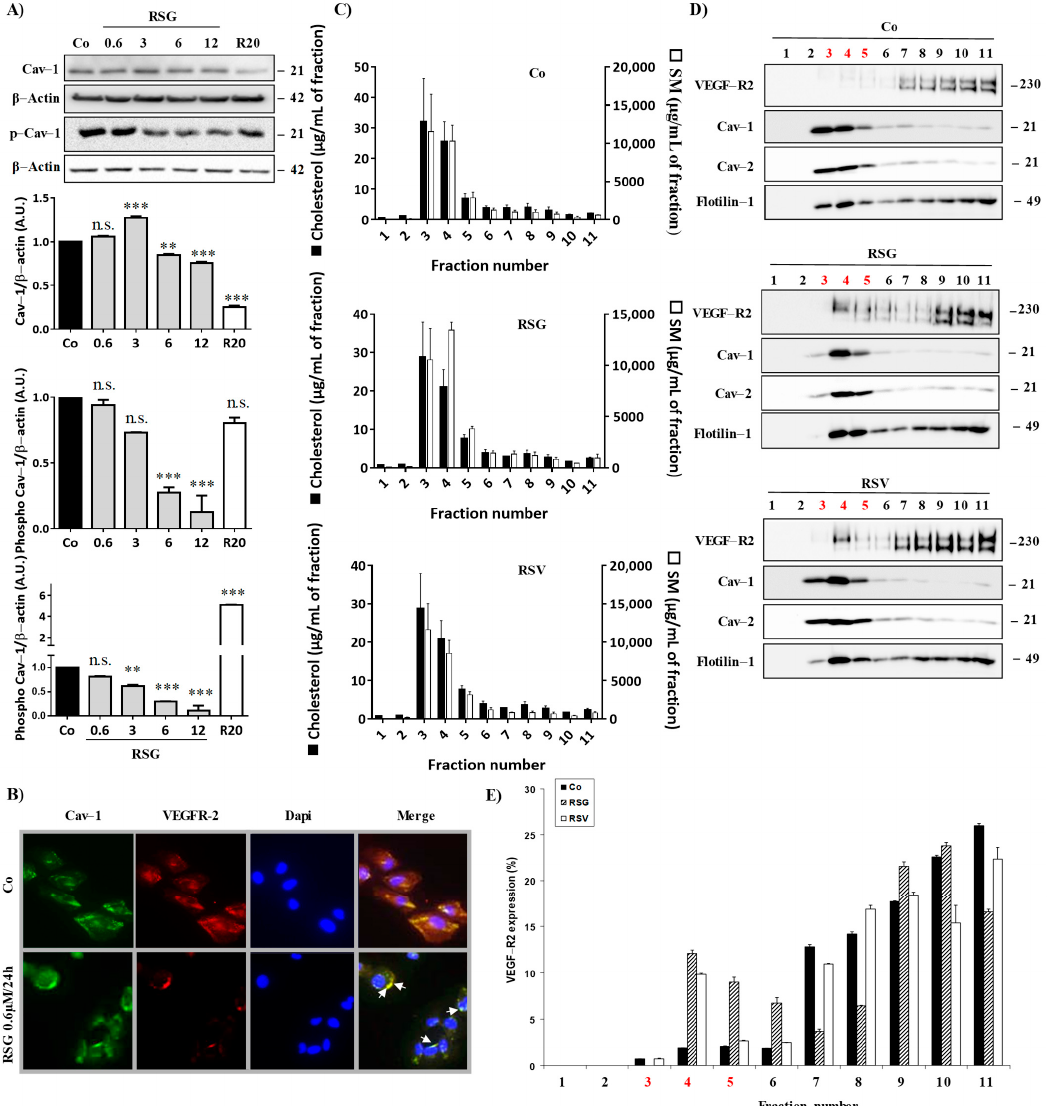
Figure 2. Disruption of VEGF-R2/Cav-1 dissociation into lipid rafts by RSV/ ω 3 fatty acids combination. ( A ) ARPE-19 retina cells were treated for 24 h by increasing concentrations of RSG (0.6, 3, 6, 12 µ M) or with RSV (20 µ M) for 24 h. A representative blot of Cav-1 and phospho-Cav-1 (p-Cav-1) is shown from three independent experiments. β -actin was used as a loading control. Densitometry quantification of western blotting is expressed as the mean fold induction ± SEM of three independent experiments. p values were determined by a one-way ANOVA followed by Tukey’s multiple comparison test. ** p < 0.01, *** p < 0.001 and n.s.: not significant. ( B ) ARPE-19 cells were left untreated (Co) or treated with 0.6 µ M RSG for 24 h before fluorescence microscopy analysis of caveolin-1 (Cav-1) and VEGF-R2 coexpression. A representative image of three independent experiments is shown. ( C ) Lipid composition of ARPE-19 cell lysate fractions after RSG (12 µ M) or RSV (20 µ M) treatment for 24 h. Cholesterol (black bars) and sphingomyelin (white bars) were expressed in µ g/mL of a fraction. Data are expressed as the mean fold induction ± SEM of three independent experiments. ( D ) The representative blot of the expression of indicated proteins in the above-defined fractions is shown from three independent experiments. ( E ) Densitometry quantification of western blotting. Data are expressed as the mean fold induction ± SEM of three independent